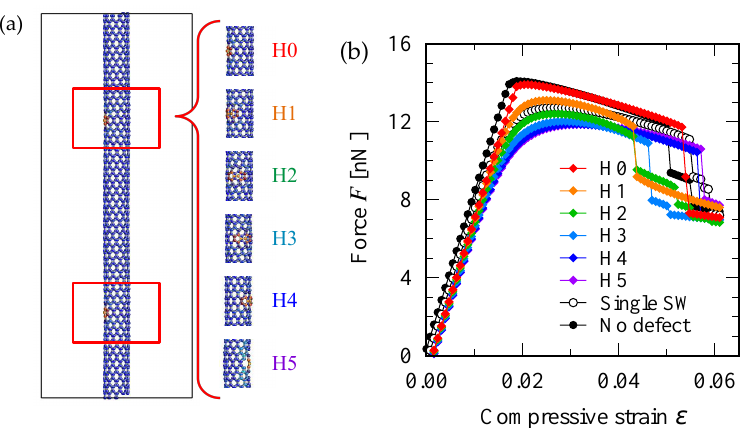
Figure 6. ( a ) Configuration of the two SW defects. The defect position is shifted in the direction hori- zontal to the circumference of the tube. ( b ) Force-strain curve for the different defect configurations. The critical point for the defect configurations labeled by H0 and H1 exceed the one-SW-defect curve, indicating the paired-defect-induced enhancement in the resistance to axial compressive force.